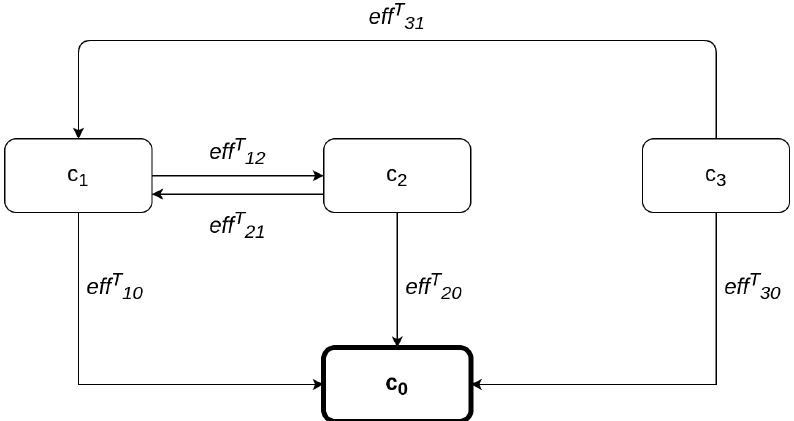
Figure 2. An example of a